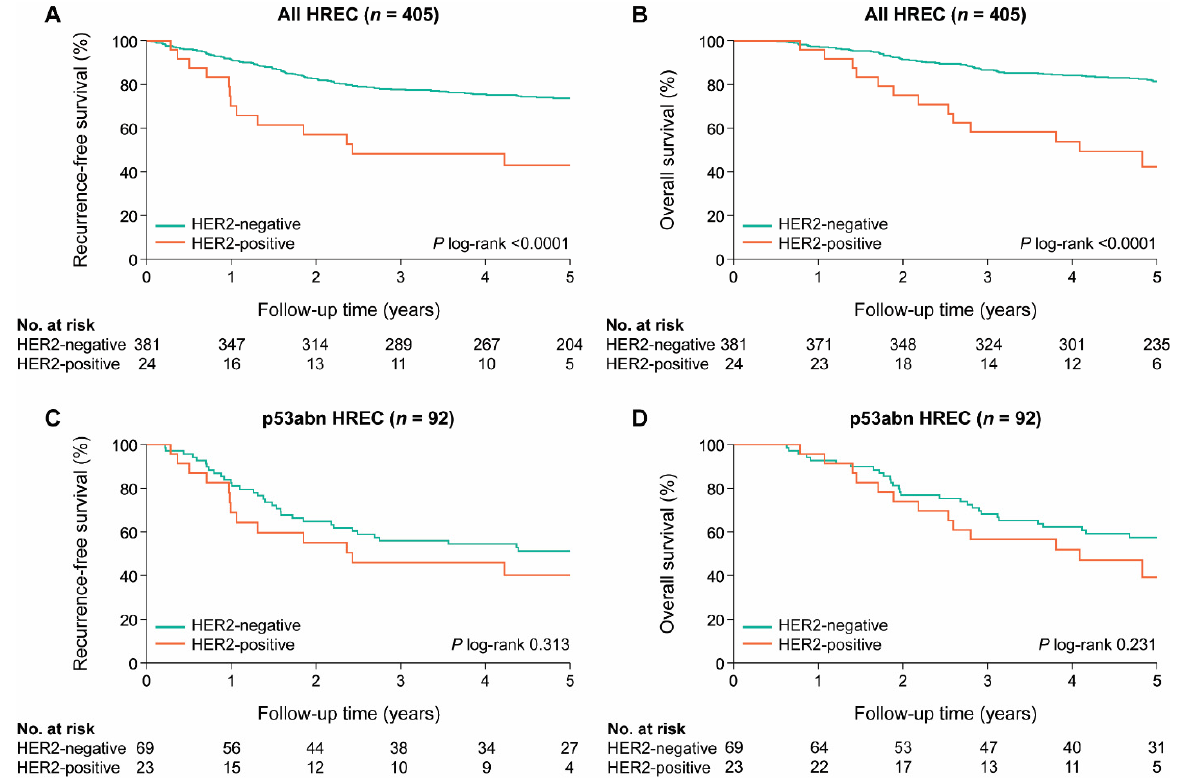
Figure 3. Kaplan–Meier survival curves for 5-year ( A ) recurrence-free survival (RFS) and ( B ) overall survival (OS) for PORTEC-3 patients with HER2-positive and HER2-negative high-risk endometrial cancer (HREC); 5-year ( C ) RFS and ( D ) OS for patients with HER2-positive and HER2-negative p53 abnormal HREC. Table 3. Multivariable analysis of the HER2 status and clinicopathological features in high-risk endometrial cancers ( n =